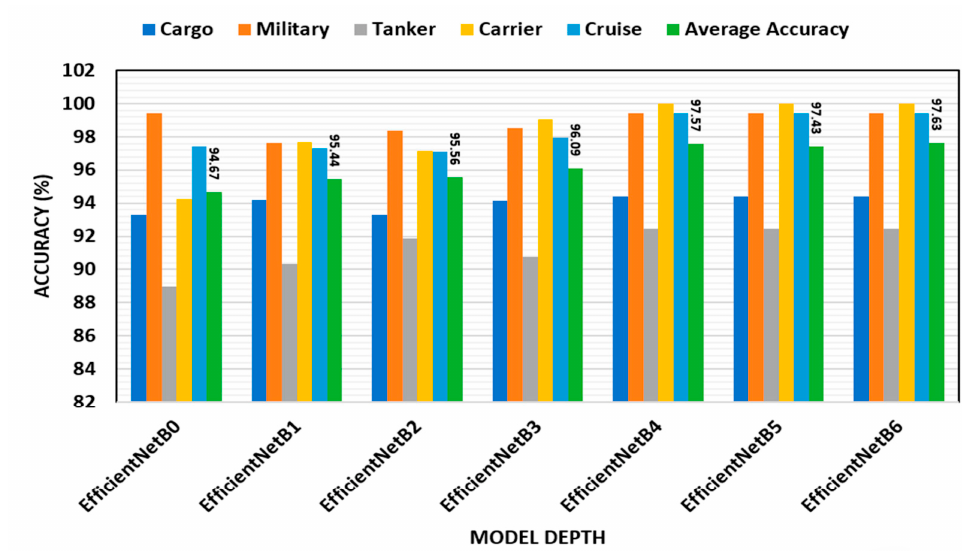
Figure 5. Different depth layers accuracy performance for ship classification dataset.